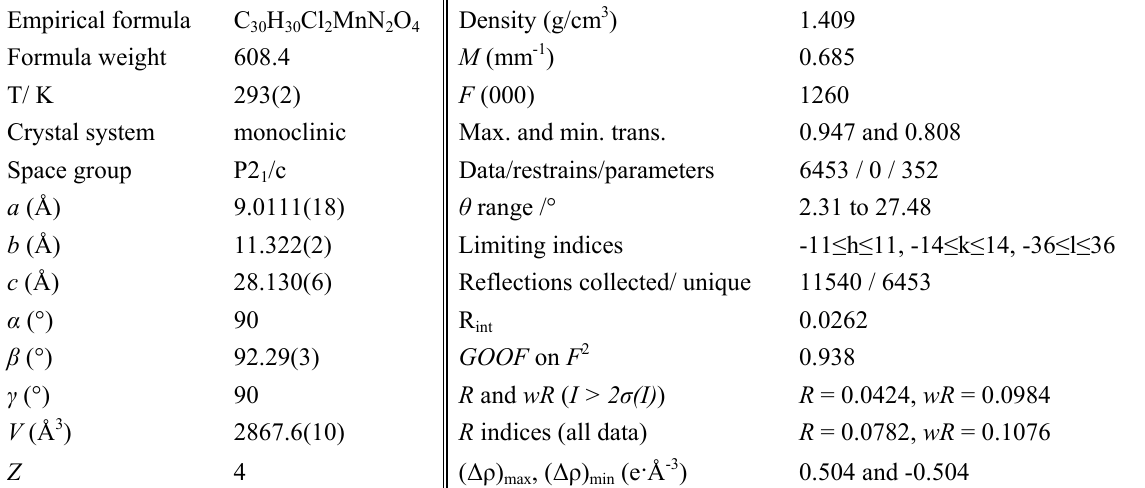
Table 4. Crystallographic Data for Complex 1.